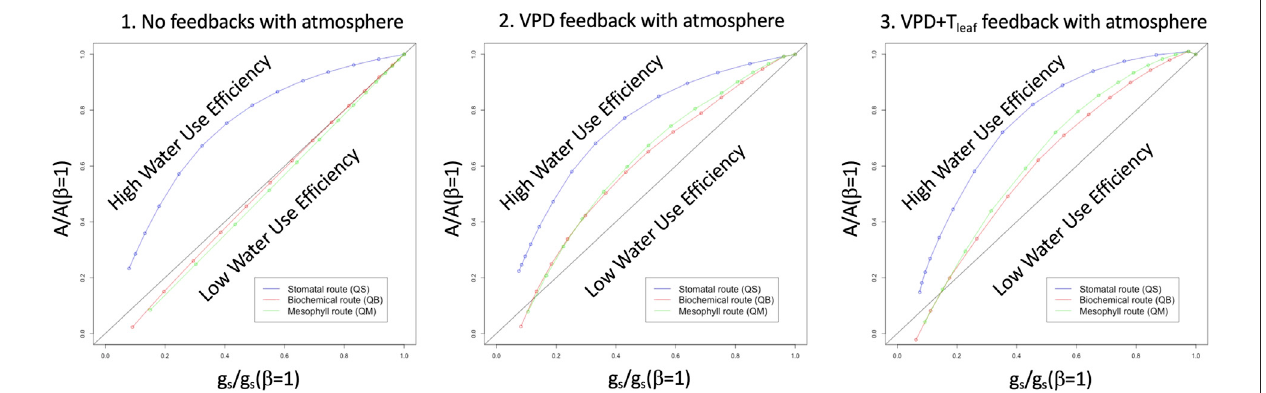
FIGURE1| IdealizedsolutionsprovidedbytheEgeaetal.(2011)model:relativestomatalconductance(g s /g s ( β (cid:1) 1), x axis)versusrelativeassimilation(A/A( β (cid:1) 1), y axis) for the three pathways and for zero feedback with the canopy air environment (left panel), VPD feedback with the canopy air environment (center panel) and VPD plus leaf temperature feedback with the canopy air environment (right panel).